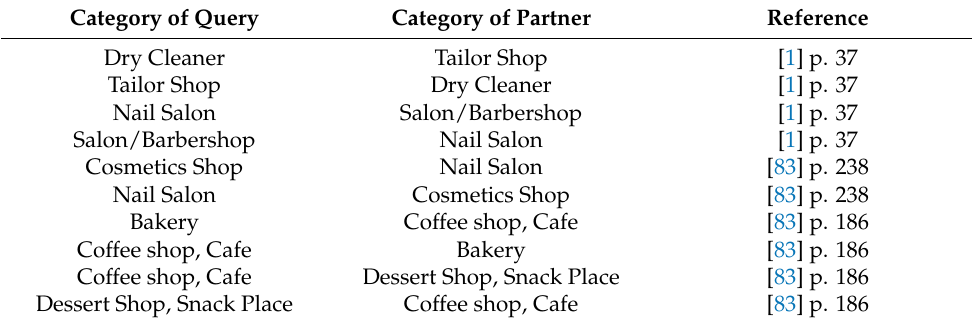
Table 6. Joint promotion cases.